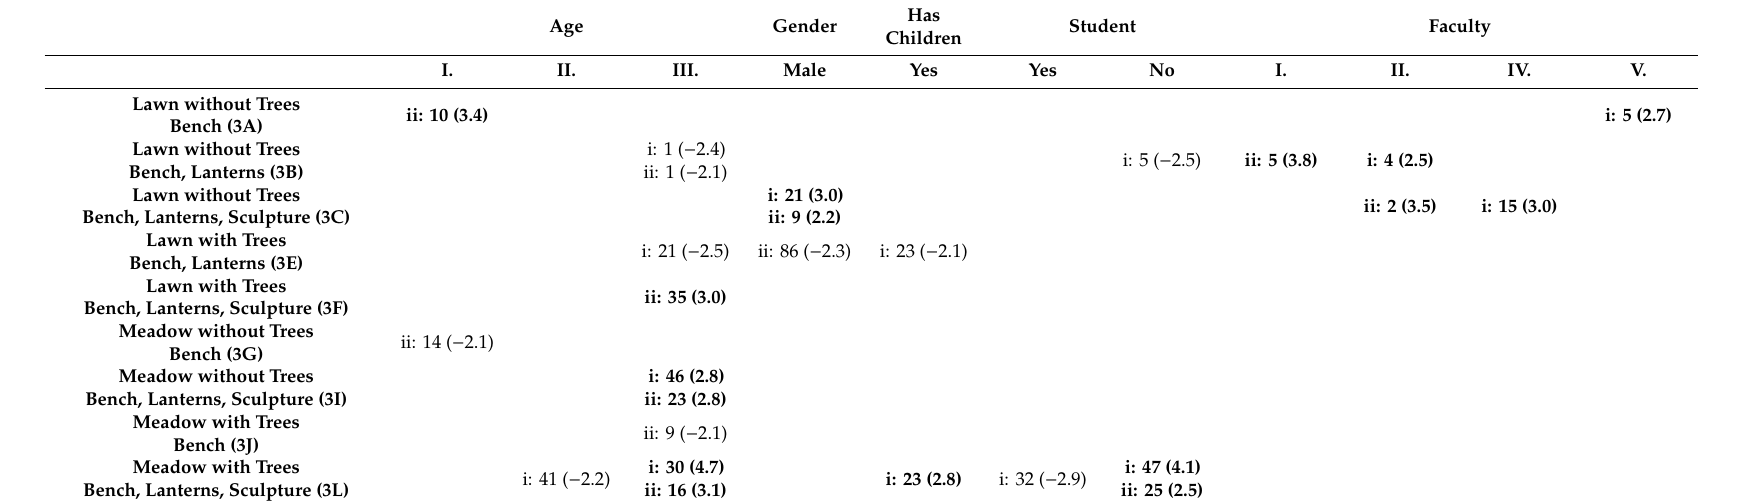
Table 6. Question 3 compared natural early summer meadows with (3J and 3L) and without (3G and 3I) trees, and lawns with (3E and 3F) and without (3A, 3B, and 3C) trees. The influence of certain structural elements on the acceptance regarding natural green spaces (without an acceptance stripe) and lawns was established here, i.e., bench placed on a lawn (3A) or a meadow (3G and 3J); bench and lanterns placed on a lawn (3B and 3E) or a meadow; bench, lanterns and sculpture placed on a lawn (3C and 3F) or a meadow (3I and 3L). The table presents the number of choices for a certain green space by the respective sociodemographic group (standardized residuals in brackets). Whereas a positive residual indicates that the scenario was appreciated by the relevant demographic group (bold type), a negative residual indicates that the scenario was disliked (normal typeface). This question was divided into four sub-questions; each image was presented twice as two separate questions: the results of (i) the first sub-question are shown in the upper line; the results of (ii) the second sub-question in the lower line. Only significant cases are listed. Has Age Gender Student Faculty Children I. II. III. Male Yes Yes No I. II. IV.